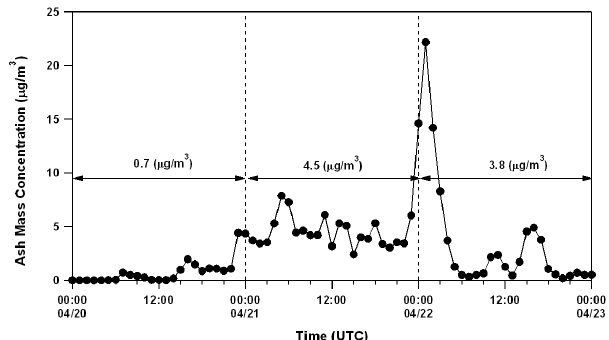
Figure 12 (M. R. Perrone et al.) Fig. 12. Time evolution at the lidar site of the volcanic ash mass concentration (µgm − 3 ) at ∼ 150ma.s.l. from FLEXPART simula- tions. Daily means on 20, 21, and 22 April are also